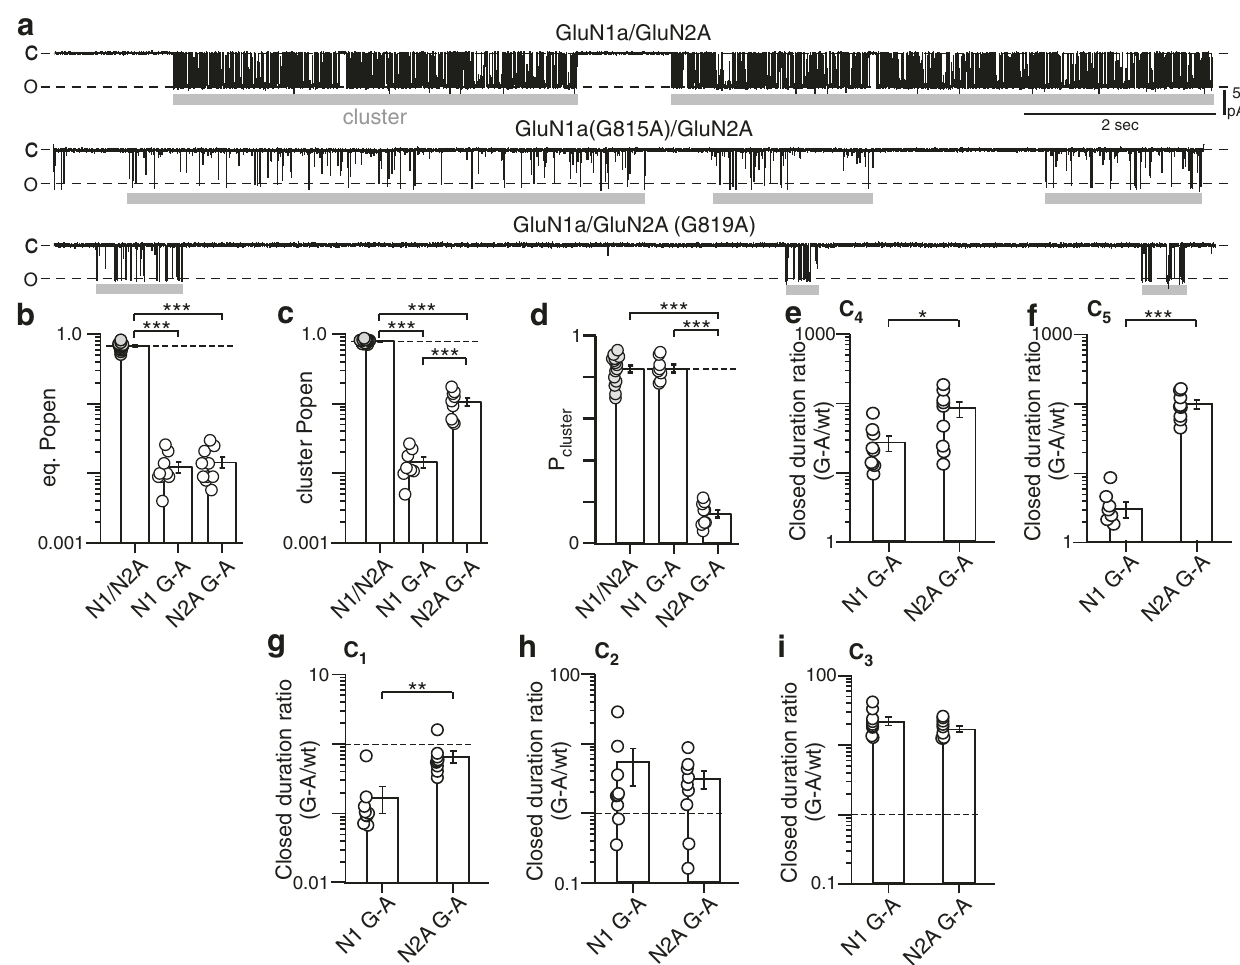
Fig. 2 | GluN1 or GluN2A M4 helices have distinct effects on the pattern of NMDARgating.a Singlechanneltracesofon-cellpatchesat − 100mVforwild-type (upper trace) or constructs containing alanine (A) substituted at the conserved glycine(G)eitherinGluN1a(G815A)(middletrace)orGluN2A(G819A)(lowertrace). (C)losed and (O)pen states are indicated. Gray bars indicate ‘ clusters ’ , which were de fi ned based on T crit . b – d Bar graphs (mean±SEM with circles indicating indivi- dual values) of single channel equilibrium open probability (eq. P open ) ( b ), cluster P open ( c ), and cluster probability (P cluster =mean cluster duration/(mean cluster duration+mean intercluster duration) ( d ). e – i Ratio of mean duration (mean± SEM) between G-A constructs and wild-type for the two slowest closed